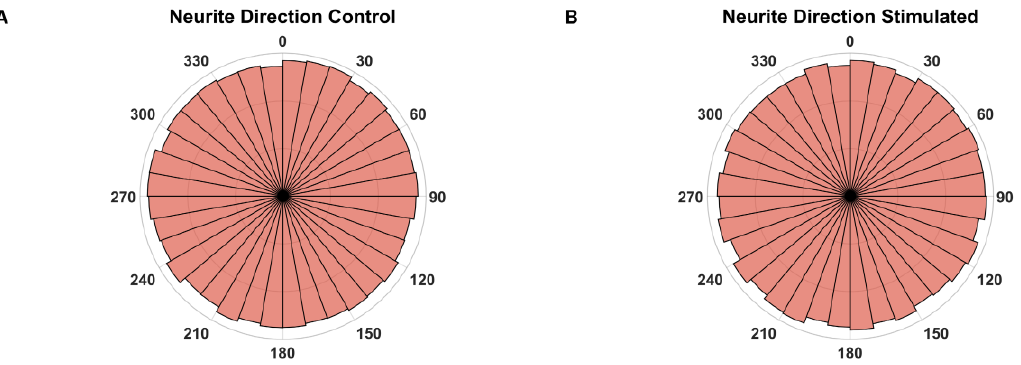
Figure 5. Growth direction angles. Polar histograms of the growth directions of every neurite from all electrically unstimulated ( A , n = 112,850) and stimulated ( B , n = 73,117) explants. The histograms are divided into 10° bins.